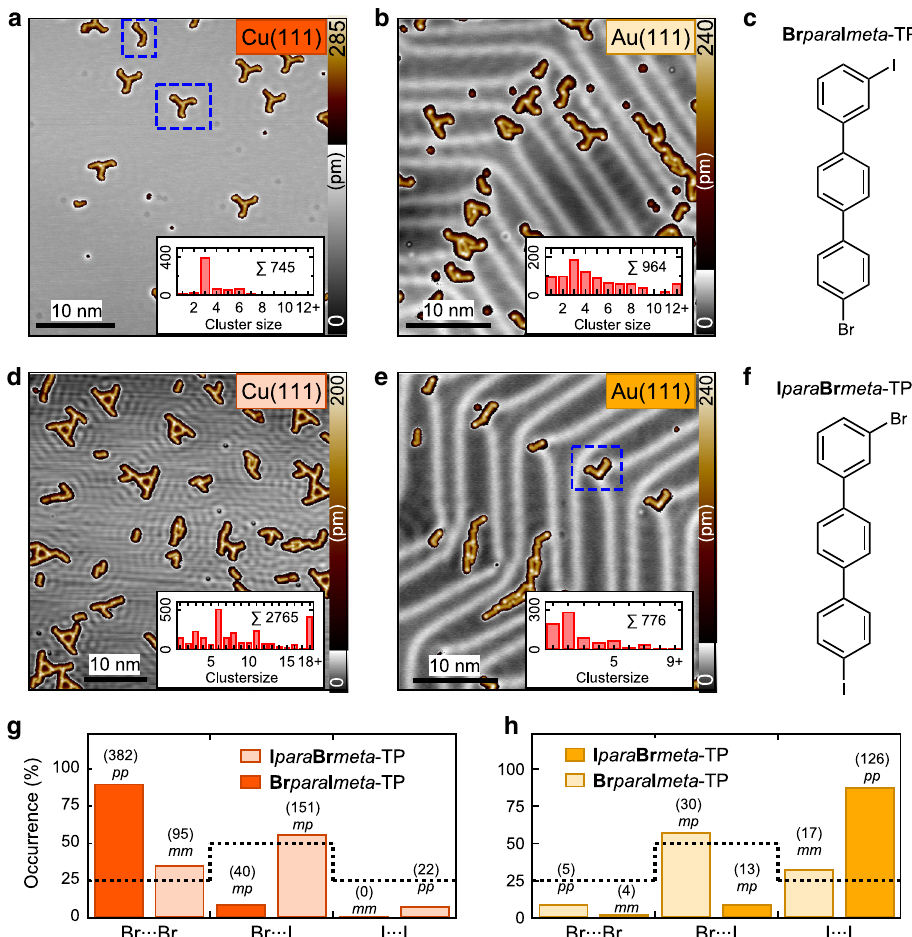
Fig. 2 Overviews of halogen bonded clusters and selectivity of halogen bonds. a , b , d , e STM overview scans of Br para I meta -TP and I para Br meta -TP on Cu(111) and Au(111). The insets give the total numbers of counted molecules that were found in clusters of a certain size. The dashed blue boxes indicate typical windmills and dimers as analyzed in Fig. 3. c , f Chemical structures of Br para I meta -TP (used in a , b ) and I para Br meta -TP (used in d , e ). g , h Statistical distribution of Br ⋯ Br, I ⋯ I, and Br ⋯ I halogen bonds on Cu(111) and Au(111), respectively. On Cu(111) only dimers and trimers and on Au(111) only dimers are analyzed. The total number of counted halogen bonds are given in parentheses. Para – para , para – meta , or meta – meta connections are indicated by italic letters. The dashed black lines represent the statistical 25:50:25% distribution that would be observed if Br ⋯ Br, Br ⋯ I, and I ⋯ I connections were equal in strength. Parameters: sample bias voltage U = 100 mV, tunneling current I = 10 pA ( a , b , e ) and I = 100 pA ( d